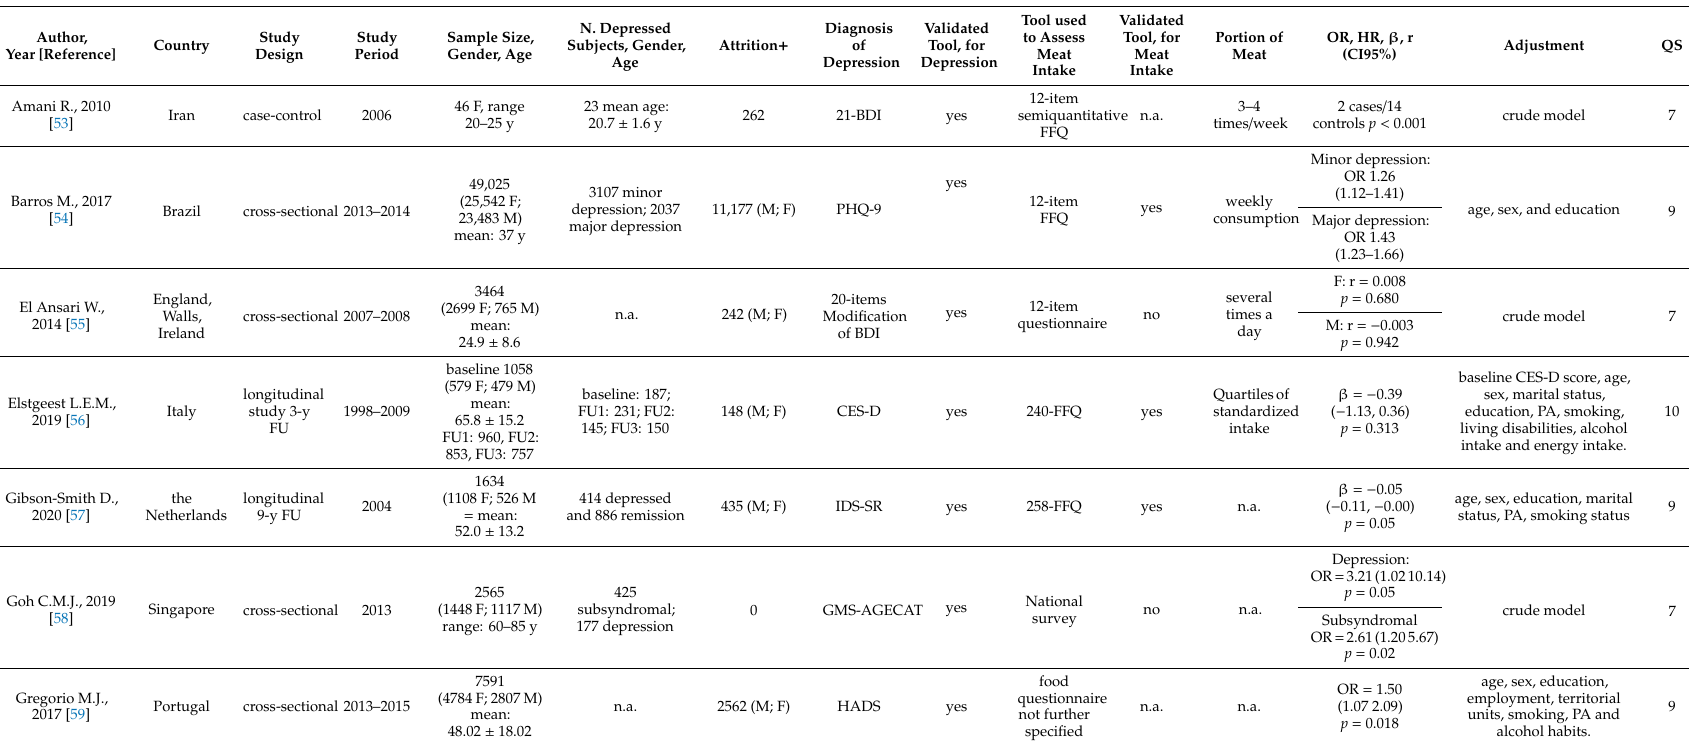
Table 2. Descriptive characteristics of the included studies listed in alphabetical